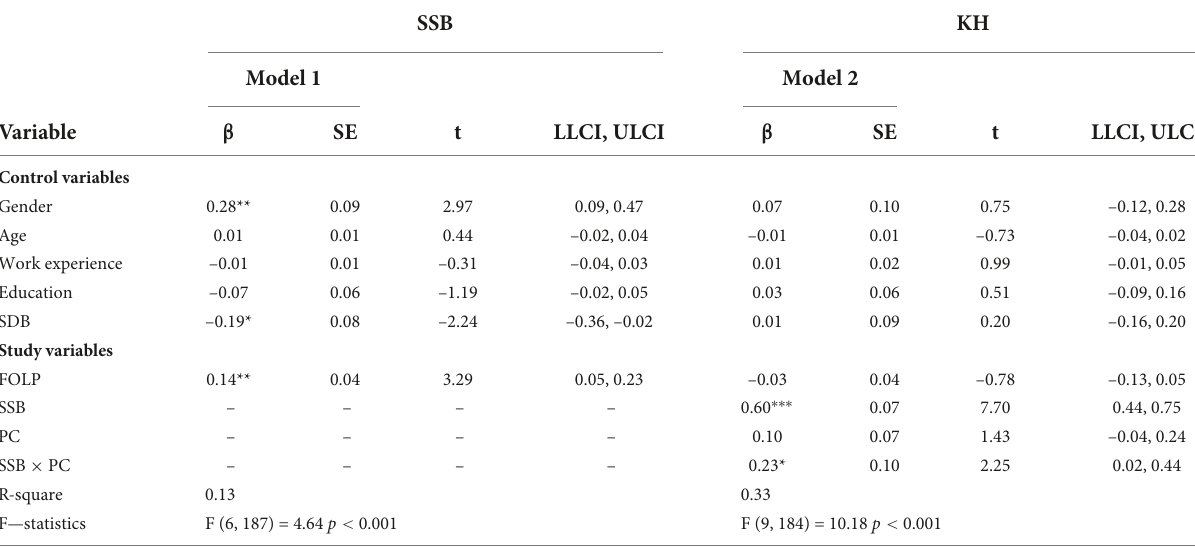
TABLE 3 Regression models and